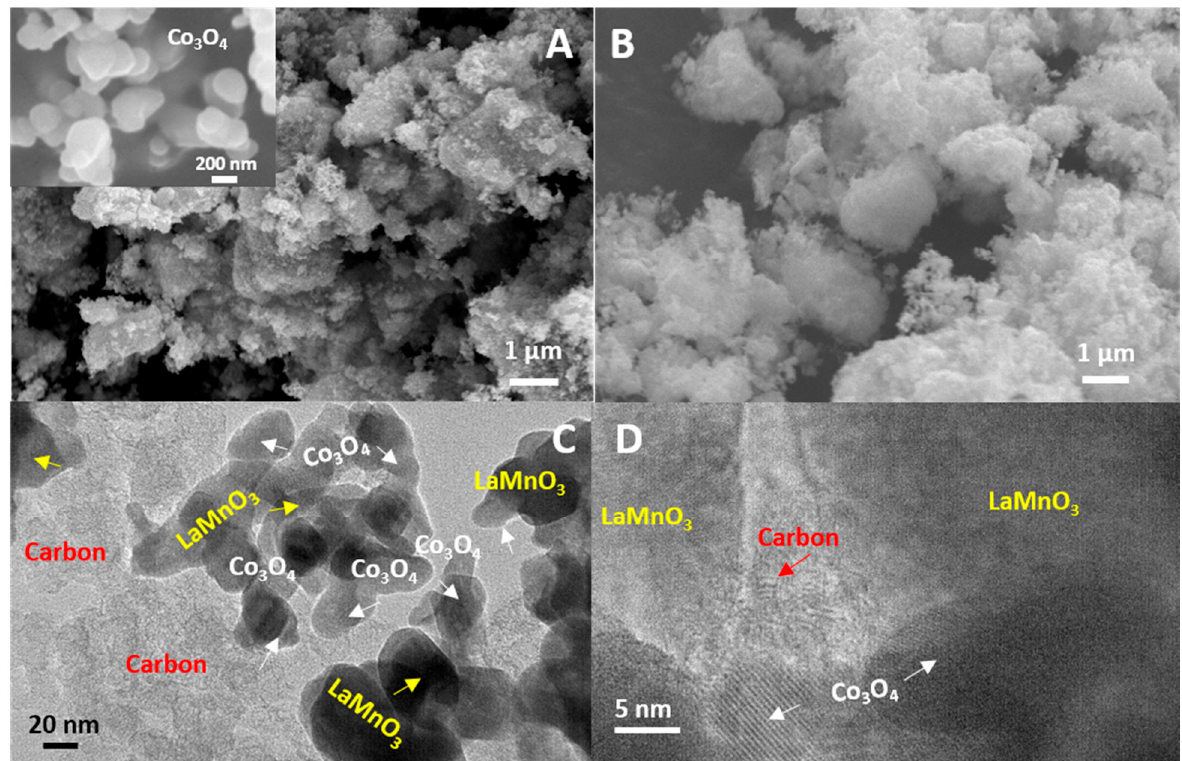
Figure 1. SEM image of LaMnO 3 ( A ) and LaMnO 3 @C-Co 3 O 4 composite ( B ); Inset ( A ) shows the SEM image of Co 3 O 4 nano/microspheres; ( C & D ) TEM images of LaMnO 3 @C-Co 3 O 4 composite catalyst.